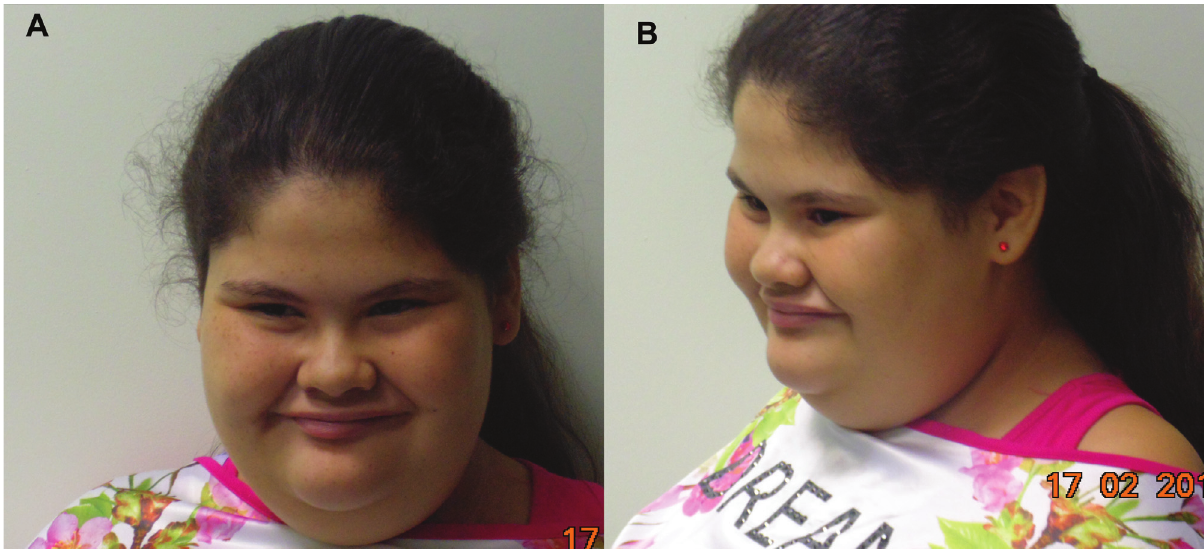
Figure 1 - Patient at 13 years. (A) Frontal view. (B) Side view. Note the frontal humps, flat cheeks, round face, full cheeks, short nose, low nasal bridge, thin upper lip and short